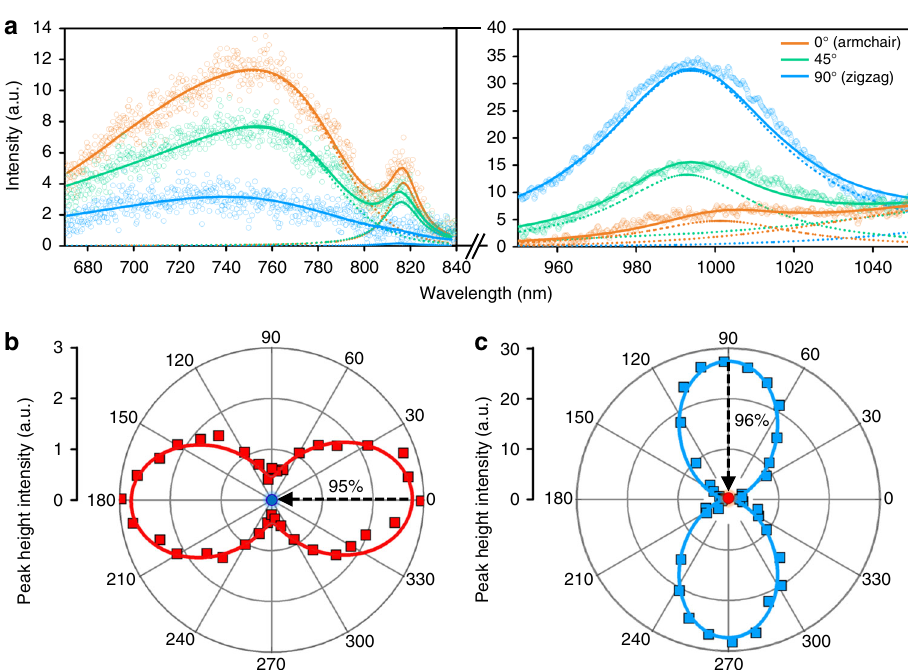
Fig. 4 Photoluminescence measurements of SnS. a Deconvolutions of PL peaks under parallel polarization at 817 and 995 nm give clear, opposite trends with respect to sample orientation, demonstrating the identity of the valley positions. b , c Polar plots of PL peak height intensities conducted under parallel polarization for the valleys at 817 and 995nm, respectively (squares). The single circular data point in each polar plot represents the PL peak height intensities of the corresponding measurements conducted with the second polarizer perpendicular to the incident light when the respective axes are aligned to the excitation polarization. The black dashed arrows connect the two data points before and after the 90° rotation of the second polarizer, showing 95% and 96% decrease in PL intensities at the Γ Y and Γ X valleys respectively. These show valley selectivity in the absorption and emission of